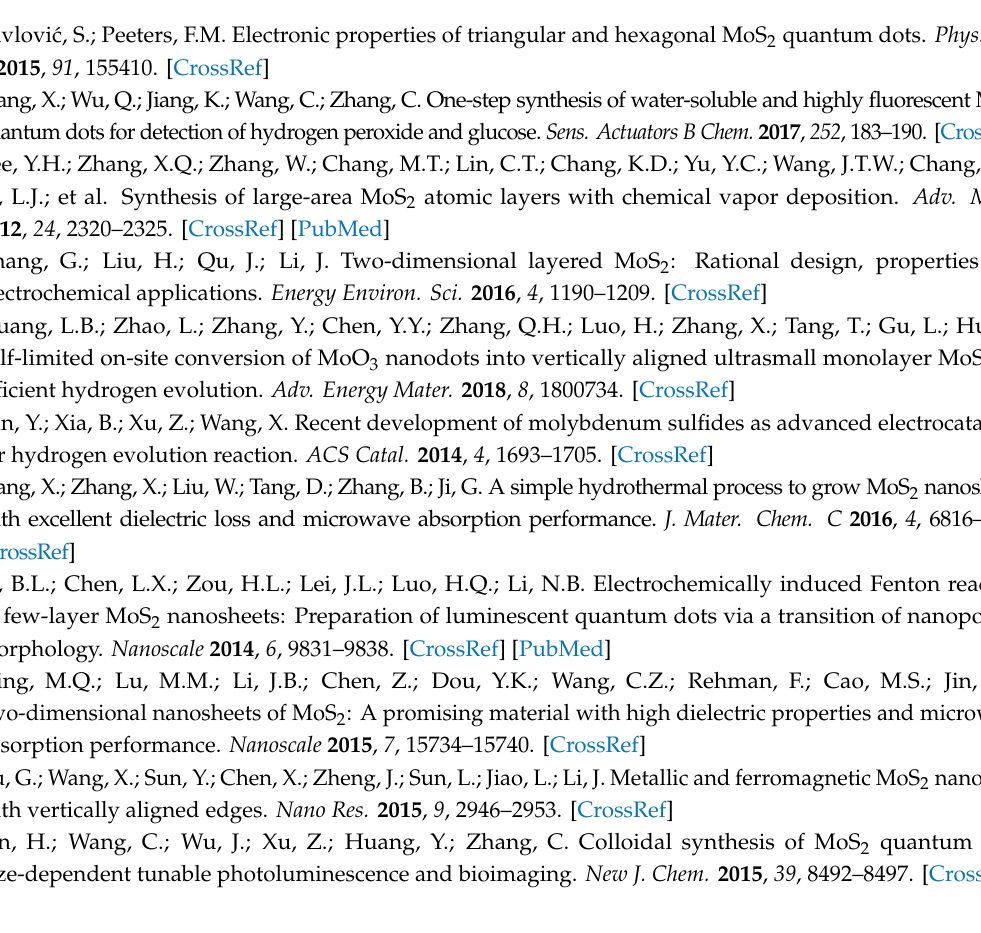
Figure S1: FL emission spectra with various excitation wavelengths of the supernatant under di ff erent peeling conditions. (A) 0.2 M NH 4 F, 5 V, 20 h; (B) 0.2 M H 2 SO 4 , 5 V, 20 h; (C) 0.2 M PBS (pH = 7.4), 3 V, 20 h; (D) 0.2 M PBS (pH = 7.4), 7 V, 20 h; (E) 0.2 M PBS (pH = 7.4), 5 V, 10 h; (F) 0.2 M PBS (pH = 7.4), 5 V, 30 h. Figure S2: XPS spectra of the S 2p peak regions of MoS 2 precursor (above) and MoS 2 precipitate (below) samples. Figure S3: (A) Bright-field and (B–D) fluorescent images of cotton fiber stained with MoS 2 QDs. The fluorescent images were obtained at the excitation wavelengths of (B) 510–550 nm, (C) 330–385 nm, (D) 450–480 nm. Scale bar: 50 mm. Table S1: To further elucidate the novelty of this work, comparison of previous works with this one. Author Contributions: Conceptualization, Y.X.; Data curation, Y.L. and X.W.; Formal analysis, Y.L. and X.W.; Investigation, Y.L.; Methodology, Y.L., M.L., and Y.X.; Project administration, M.L. and Y.X.; Resources,